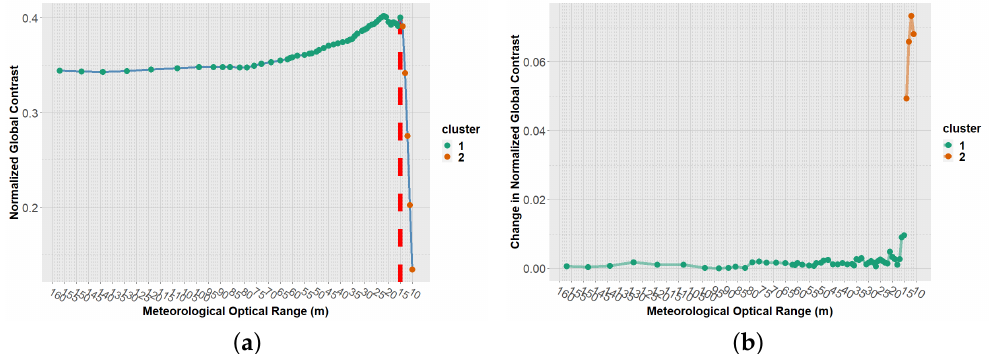
Figure 21. Contrast attenuation and identification of the operational threshold. ( a ) NGC vs. MOR; AOV-18°, Distance-10 m, Target-50 °C; ( b ) Clustering according to change in